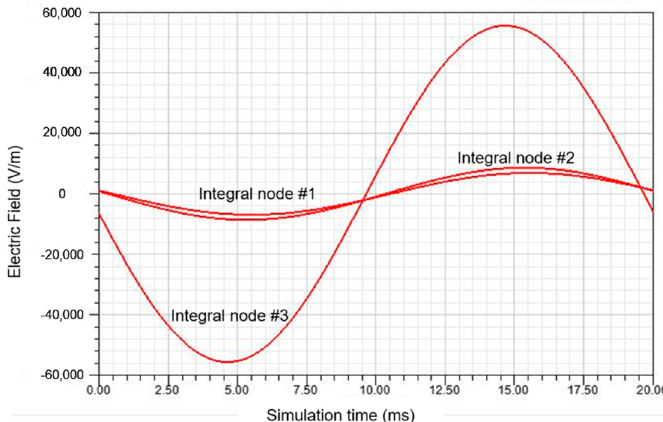
Figure 8. E-field waveform at reconstructed node position.